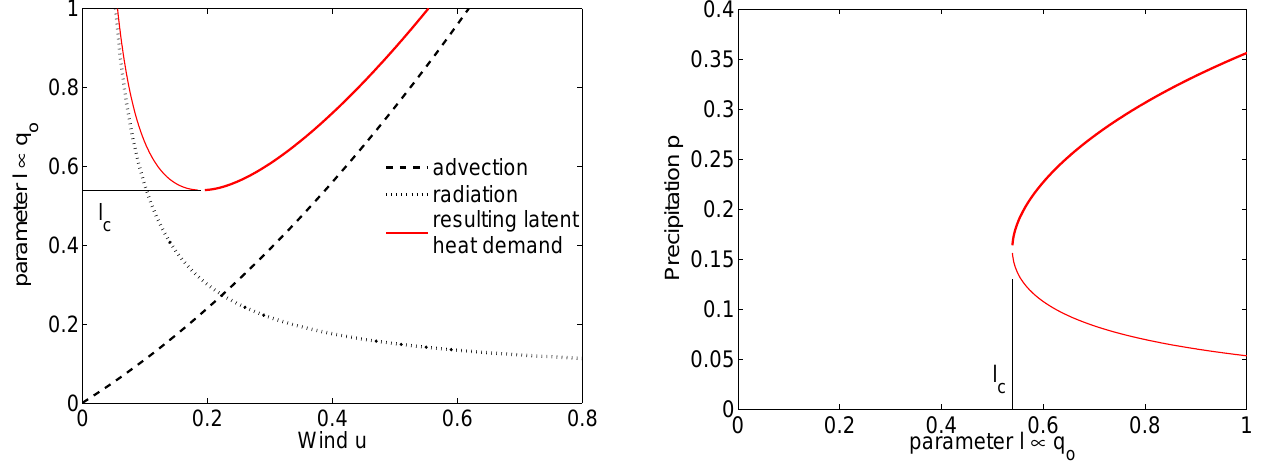
Fig. 6. As Fig. 5 (red line), but in terms of non-dimensional precip- itation p , and organized with the control parameter l on the